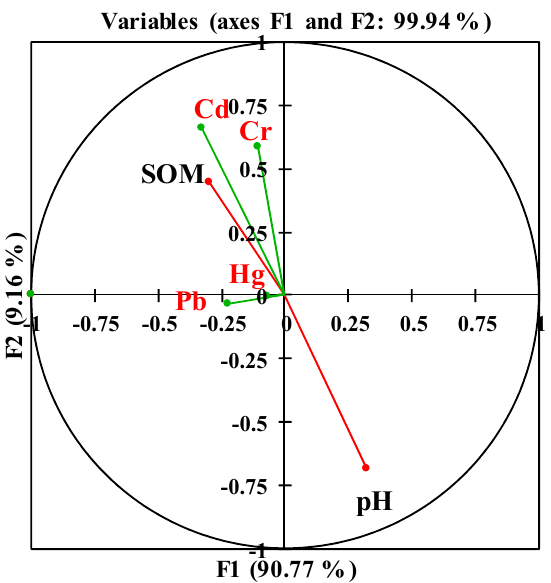
Figure 3. Ordination diagram based on the CCA of soil properties (in black) and heavy metals (Cd, Hg, Pb, and Cr) in the soil (in red).